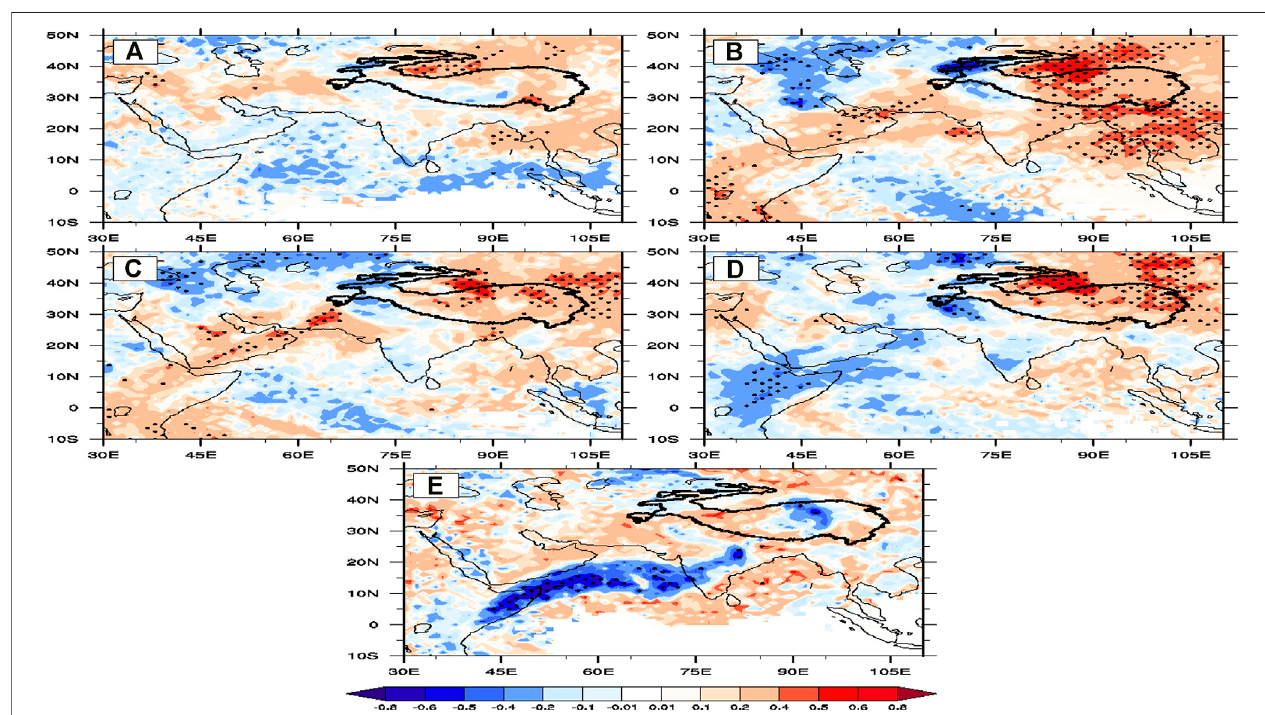
FIGURE4| DistributionfortheinterannualtrendoftheLagrangianE-Pdiagnosedmoisturesourcescontributionofthe fi vecategoryprecipitationeventsfor (A) dry, (B) light, (C) moderate, (D) heavy, and (E) extremely heavy, respectively. The dotted regions are signi fi cant at the 95% con fi dence level.